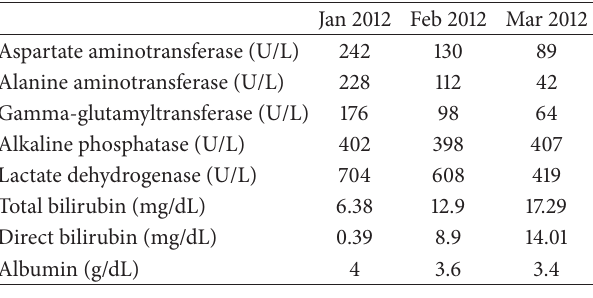
Figure 2: Inguinal lymph node examination shows mixed cellular type HD with Reed-Sternberg cells (hematoxylin-eosin stain; origi- nal magnification ×